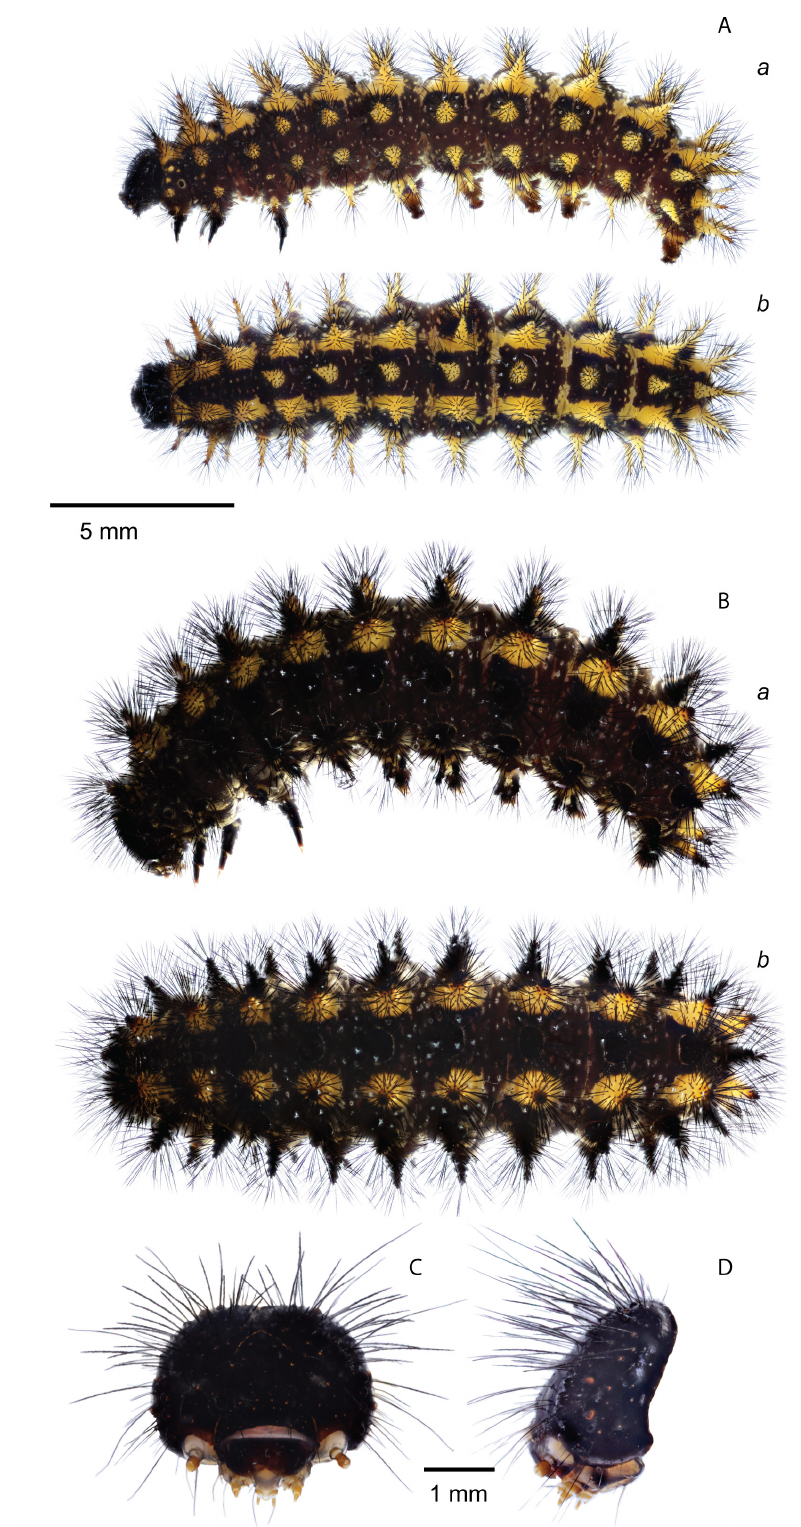
Fig. 26. V–VI instar caterpillars of Melitaea shahvarica sp. nov. (a = view from above; b = lateral view). A . Fifth instar caterpillar. B . Sixth instar caterpillar. C . Sixth instar caterpillar, head capsule, front view. D . Sixth instar caterpillar, head capsule, lateral